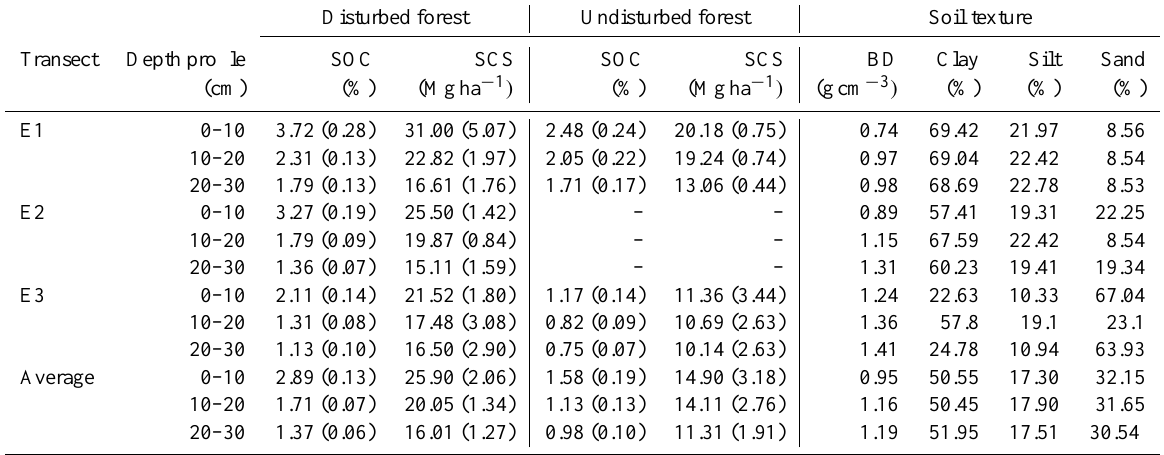
Table 1. Average concentrations of soil organic carbon content (SOC), soil carbon stocks (SCSs), bulk density (BD), and clay, silt, and sand average concentrations in transect 1 (E1), transect 2 (E2), and transect 3 (E3). Values in brackets represent the standard error of the mean. Disturbed forest Undisturbed forest Soil texture Transect Depth